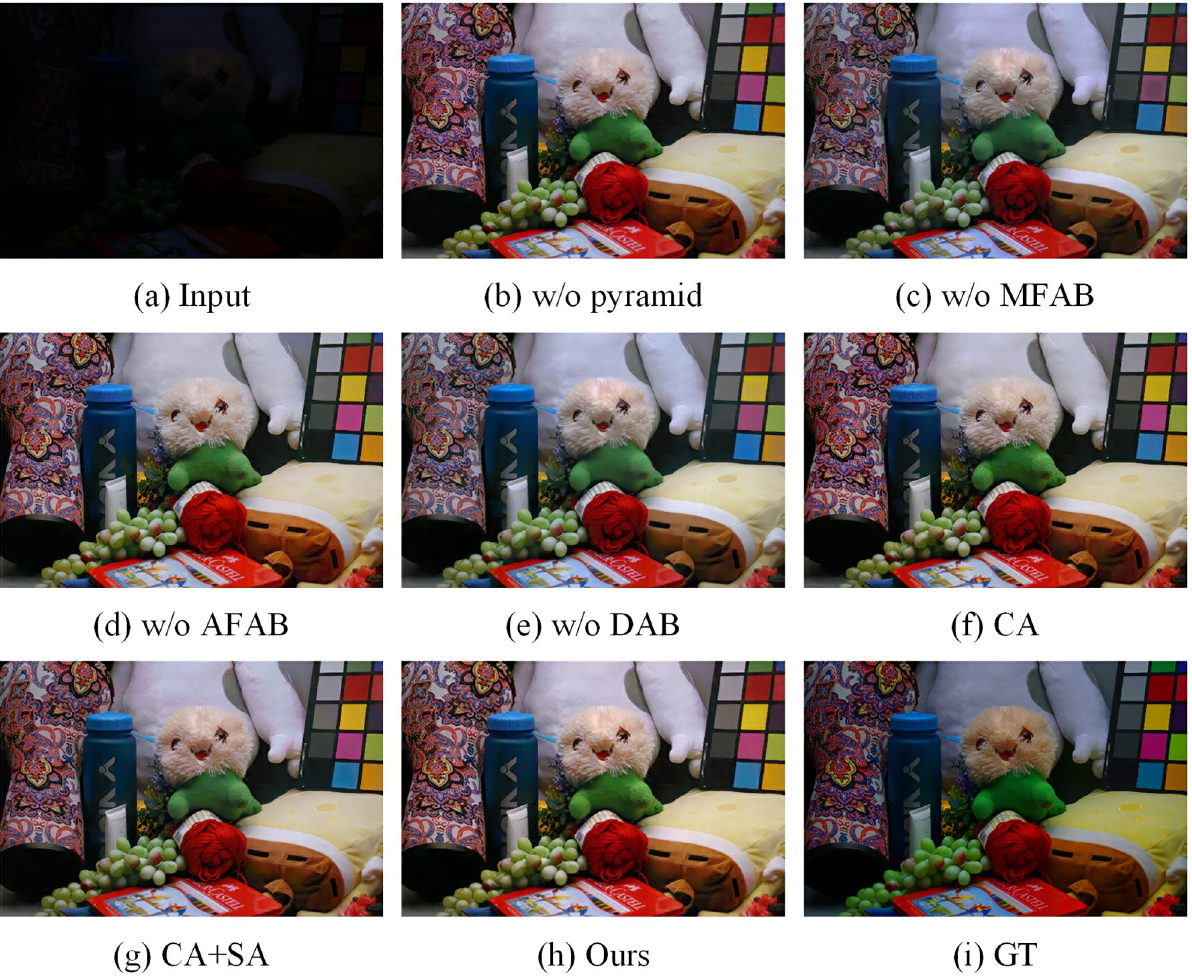
Fig 10. Visual results of models with different components on LOL dataset. (a) Input. (b) w\o pyramid. (c) w\o MFAB. (d) w\o AFAB. (e) w\o DAB. (f) CA. (g) CA+SA. (h) Ours. (i) GT.